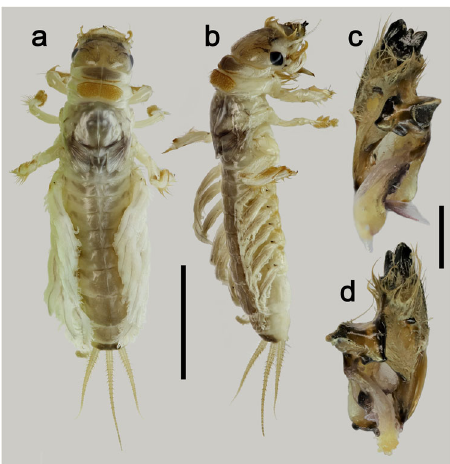
Fig. 6 Nymph of the rock-boring may fl y species Languidipes lithophagus sp. nov. from Bago River, Myanmar. a Holotype RMBH N54_8 (dorsal view); b holotype (lateral view); c left and d right mandible (dorsal view). Scale bars = 5 mm ( a , b ) and 1 mm ( c , d ). (Photos: Elizaveta A.